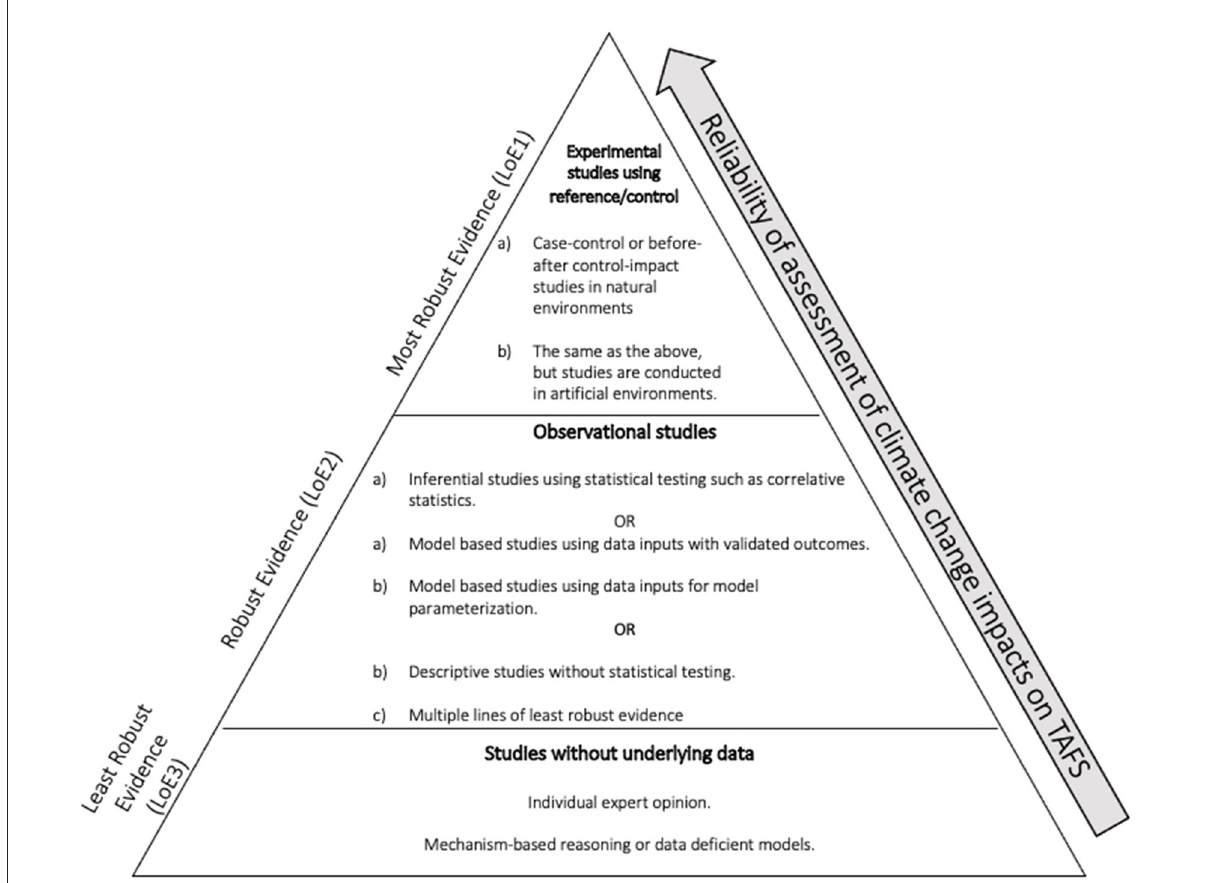
FIGURE2 Hierarchy of evidence quality according to study design, with internally ranked sub-levels a, b and c. Adapted from Mupepele et al.